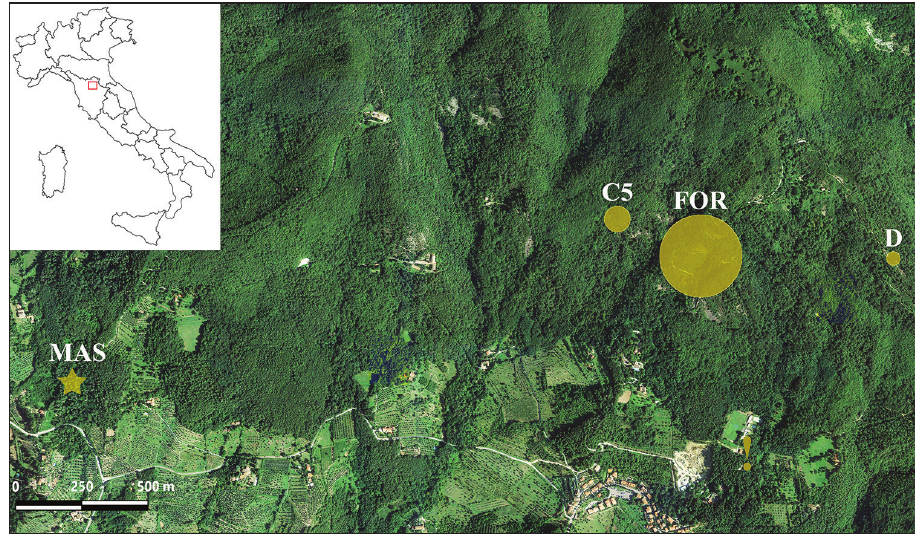
Figure 1. Distribution map of the Italian population of C. laurifolius L. subsp. laurifolius . Yellow symbols in- dicate the location of each sub-population. Circle size is proportional to the area occupied by the sub-popula- tions of Fornellaccio (FOR), Fontassenzio (D) and west of Fornellaccio (C5). The yellow star, not proportional to the area of occupancy, refers to the small sub-population of Masseto (MAS). The exclamation mark (bottom right) indicates the single individual surviving in the near proximity of the village of Santa Brigida (not in- vestigated in this study). In the top left corner, the location of the study area (red square) in Italy is